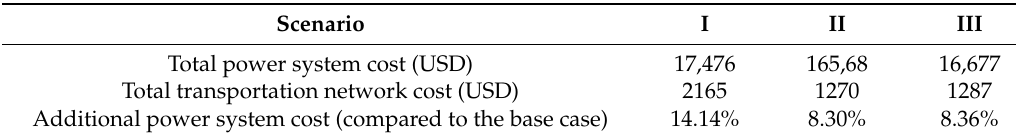
Table 3. Comparison between total power systems cost and transportation network cost for different scenarios in the presence of PHEVs.